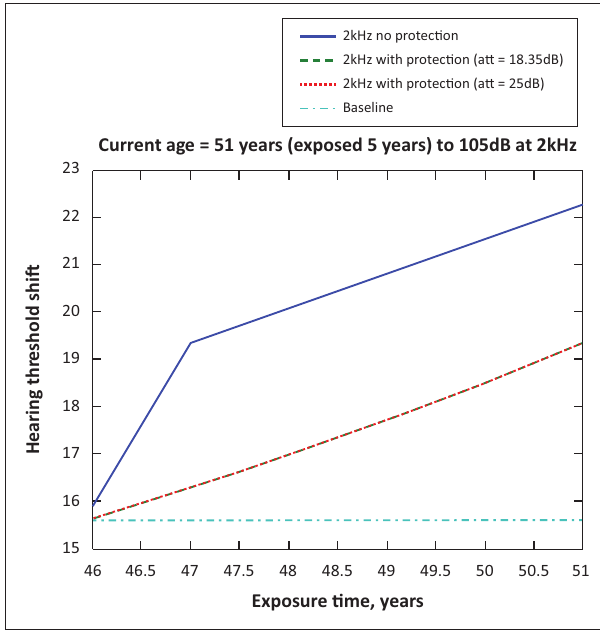
Source : Figure created using data from Moroe, N.F. (2018). Occupational noise-induced hearing loss in South African large scale mines: From policy formulation to implementation and monitoring . Doctoral thesis. Johannesburg: University of the Witwatersrand. FIGURE 15: Fifty-one years old at 2000 Hz with exposure levels of 105 dB.